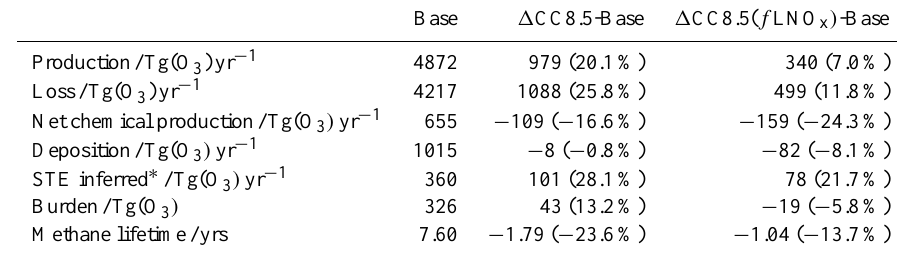
Table 2. Tropospheric O x budget of the Base run and changes from Base to 1 CC8.5 and 1 CC8.5( f LNO x ) ,with absolute values reported to the nearest integer. The Base methane lifetime and its changes are also reported.